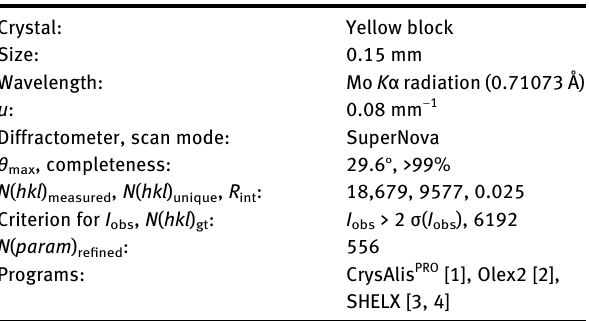
Table 2 contains the list of the atoms including atomic coordinates and displacement parameters.